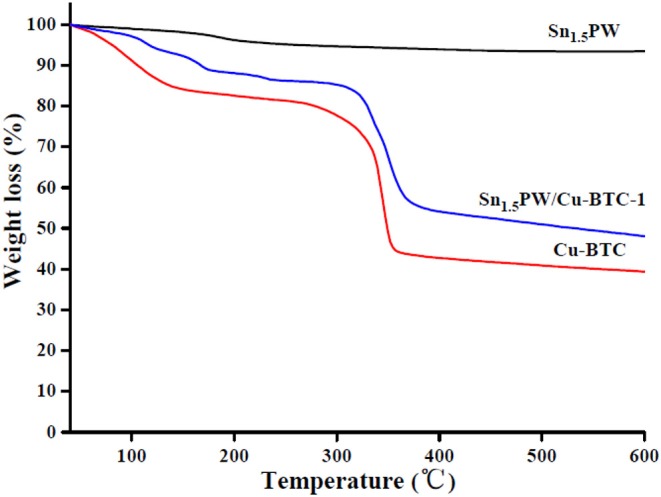
TG curves of Sn1.5PW, Cu-BTC, and Sn1.5PW/Cu-BTC-1 samples.